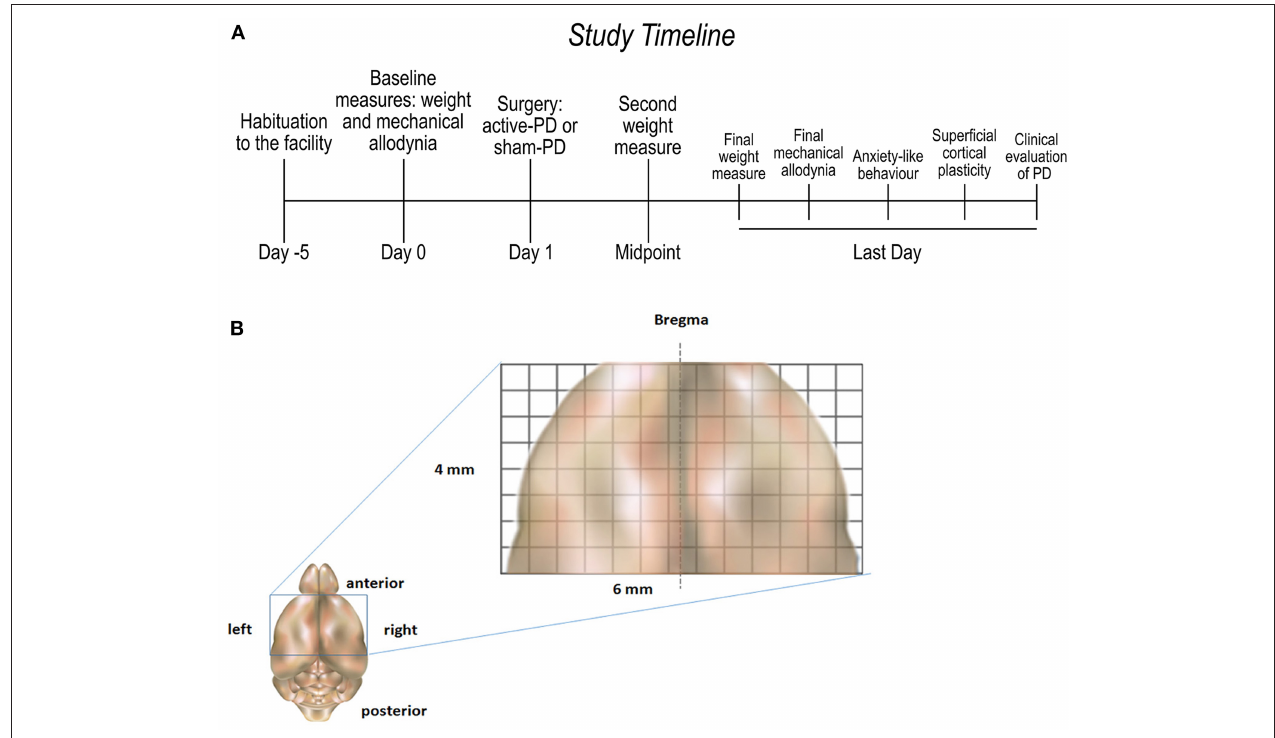
FIGURE 1 | Study timeline (A) and illustration of the rat motor cortex area (B) . PD, periodontal disease; Midpoint, day 7 for Acute group and day 14 for Chronic group; Last day, Day 14 for Acute group and day 28 for Chronic